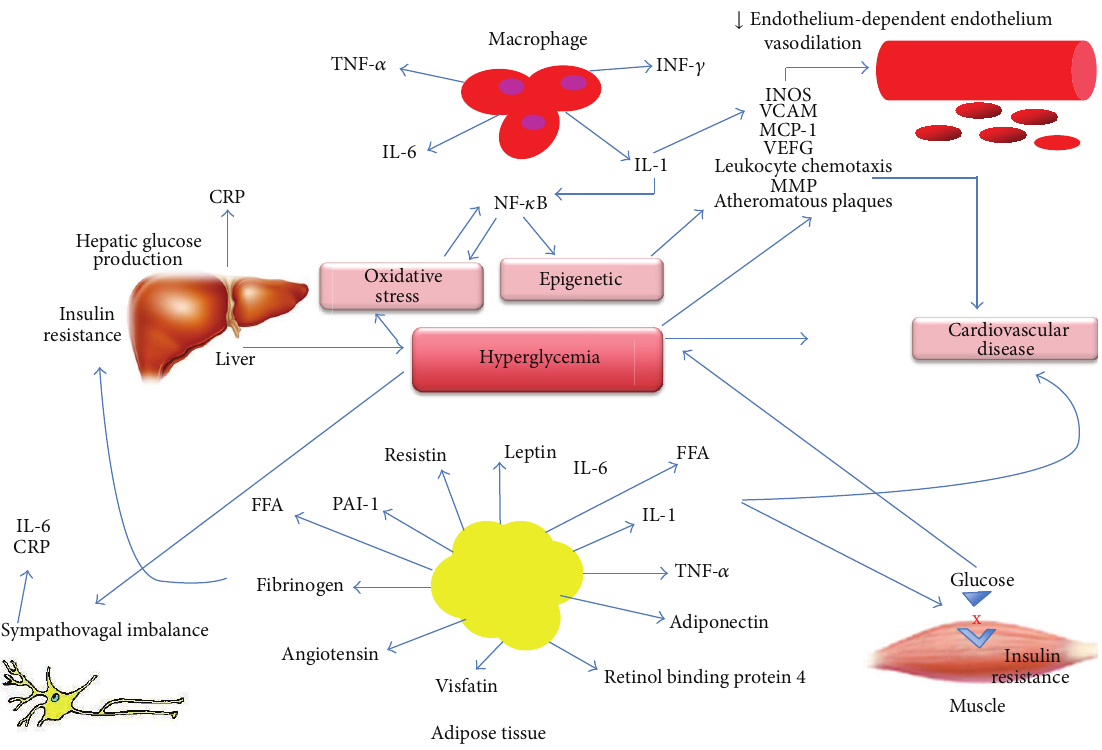
Figure 1: Pathogenesis of cardiovascular disease in diabetes. The mechanisms involved in the pathogenesis of cardiovascular disease in diabetes comprehend epigenetic changes and intracellular metabolic changes that result in oxidative stress, low-grade inflammation, and endothelial dysfunction. CRP: C-reactive protein; FFA: free fatty acids; INOS: inducible nitric oxide synthase; IL-1: interleukin 1; IL- 6: interleukin 6; MCP-1: monocyte chemoattractant molecule 1; MMP: matrix metalloproitenase; NF- 𝜅 B: nuclear factor kappa- 𝛽 ; PAI-1: plasminogen activator inhibitor-1; VCAM-1; vascular cell adhesion molecule-1; VEFG: vascular endothelial growth factor; TNF- 𝛼 : Tumor necrosis factor- 𝛼 ; INF- 𝛾 : Interferon- 𝛾